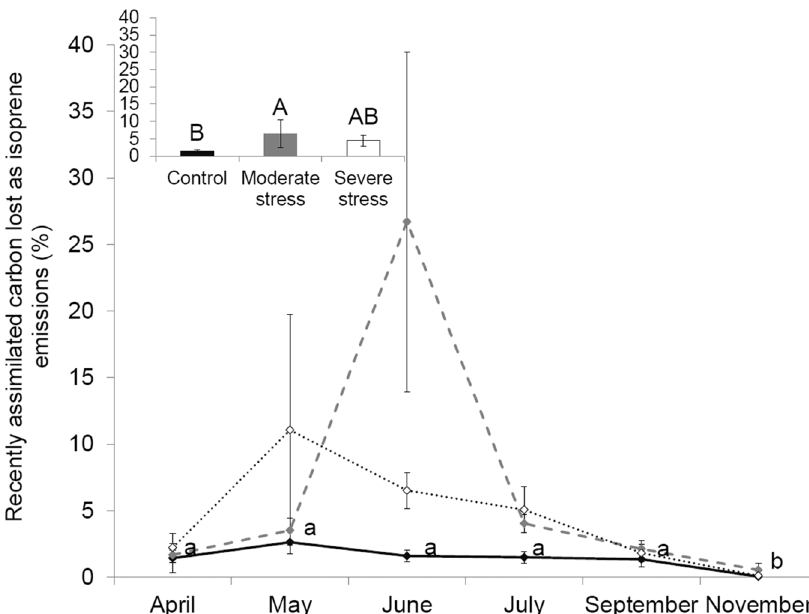
Figure 3. Isoprene emission rate as percentage of carbon re-emitted. Seasonal course of the percentage of photosynthetically assimilated carbon re-emitted as isoprene under control (– X –), mild ( ) and severe ( ??? e ??? ) water stress. Differences are tested using a two-way ANOVA (F) repeated measurements followed by Tukey tests. Since interaction between seasonality and treatment is not significant according to the two-way ANOVA, results of water stress impact are shown in the small embedded graph where data of all months are pooled together and differences between treatments are denoted by capital letters (A . B) while seasonality impact is shown in the main graph (in lower case letters: a . b). Values are mean 6 SE of n=5 saplings.